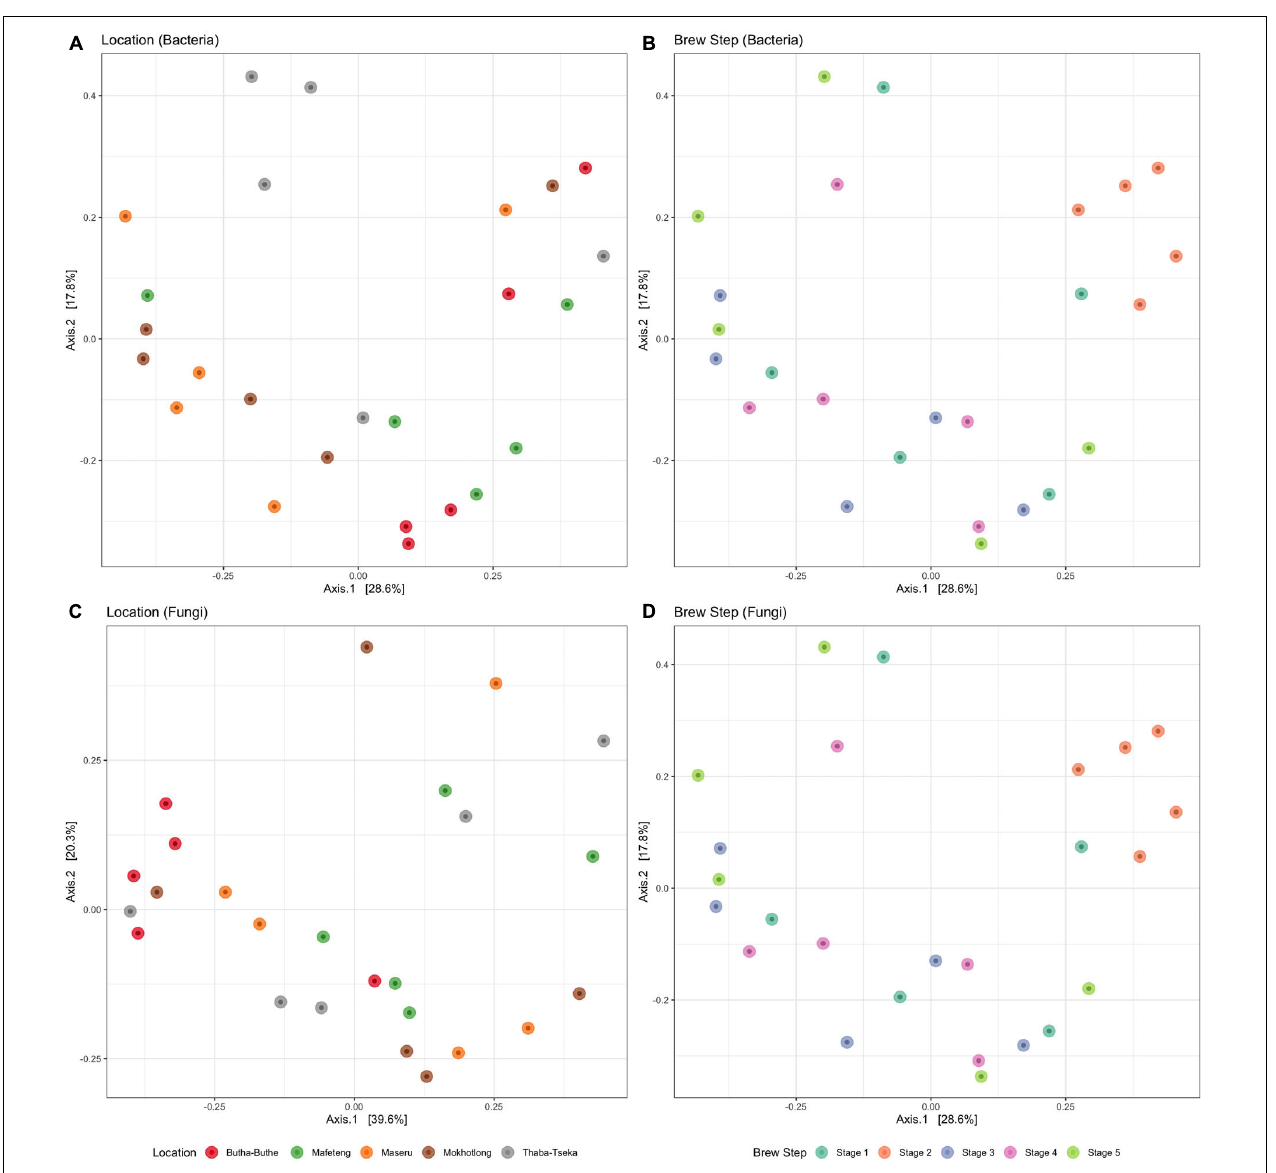
FIGURE 7 | PCoA plots for Sesotho bacterial (A,B) and fungal (C,D) communities, grouping by location (A,C) , and brew step (B,D) .